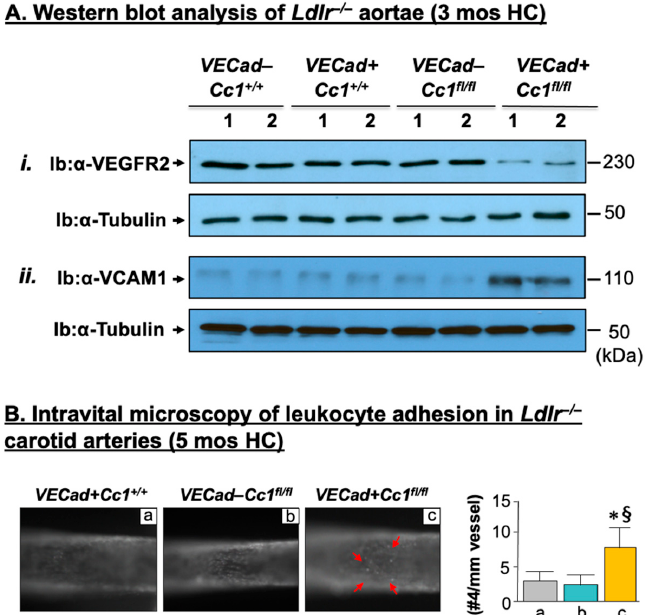
Figure 4. Leukocyte adhesion. ( A ) As in the legend to Figure 2, mice were fed a HC for 3 months and their aorta lysates were subjected to immunoblotting with (i) α -VEGFR2 and (ii) α -VCAM1 followed by probing with α -Tubulin for normalization. Gels represent analysis on 2 mice/genotype performed on different sets of mice/protein. ( B ) Mice ( n ≥ 5/genotype) were fed a HC for 5 months before their carotid arteries were isolated from the surrounding tissues and intravital microscopy of leukocyte adhesion was assessed, as described in the methods section. Cells that adhered to the vessel wall without rolling or moving for at least 3 sec (red arrows) were counted over the vessel observed by using an intravital microscope. Video images were analyzed offline for leukocyte adhesion. Total numbers were used for statistical analysis. Values were expressed as mean ± SEM and represented in the accompanying graph. * p < 0.05 vs. Ldlr − / − VECad+Cc1 +/+ (a, white bar) and § p < 0.05 vs. Ldlr − / − VECad–Cc1 fl/fl (b, grey bar).